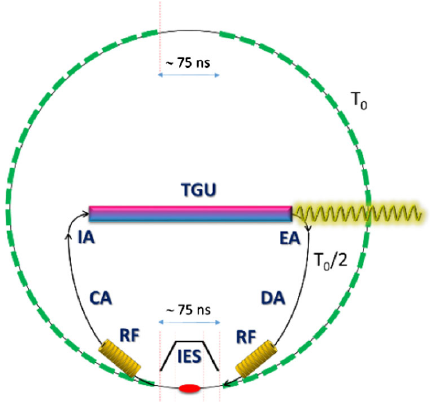
FIG. 1. SRLS upgraded to high-gain FEL. CA ¼ compressive arc, DA ¼ de compressive arc, IA ¼ injection arc, EA ¼ extraction arc, and IES ¼ injection and extraction system. Lasing bunches are in a dark gap of 75 ns.